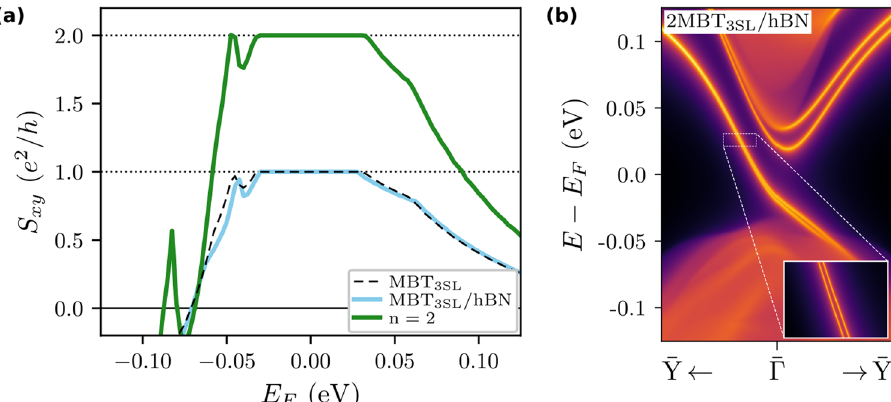
Fig. 5 Anomalous Hall conductance and edge spectra for the n MBT 3SL /hBN multilayers. a The Fermi energy dependence of the anomalous Hall conductance S xy ( E F ) in the units of conductance quantum e 2 / h for MBT 3SL , MBT 3SL /hBN, and 2MBT 3SL /hBN. E F = 0 corresponds to the center of the band gap in each case. b The edge electronic structure of 2MBT 3SL